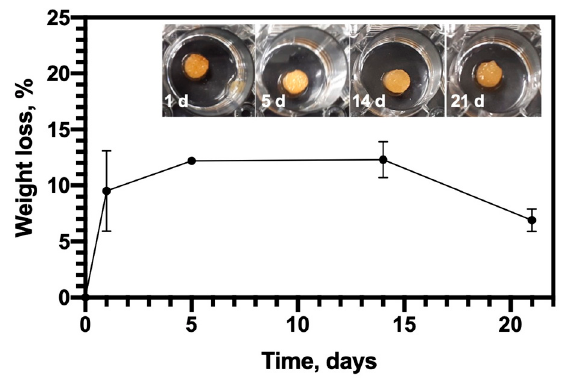
Figure 4. Biodegradation of CHT/PCD sponge (expressed in percentage of weight loss) in PBS (pH 7.4) supplemented with 0.5 mg/mL lysozyme at 37 °C and 80 rpm and representative images of scaffolds removed after each time point up to 21 days. The test was carried out at least twice and each in triplicate ( n = 6).